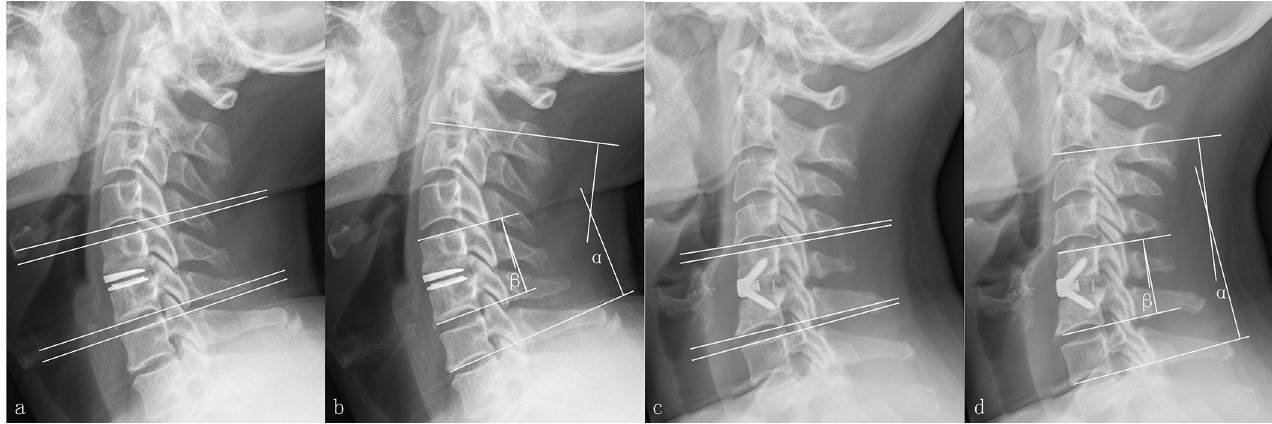
Fig 1. The methods about measurements of radiographic parameters. The range of motion (ROM) at the adjacent levels by disc space angle in the Discover group (a). The overall alignment of C2-C7 ( α ,OSA) and functional spinal unit ( β ,FSU) angle in the Discover group (b). The range of motion (ROM) at the adjacent levels by disc space angle in the Zero-P group (c). The overall alignment of C2-C7 ( α ,OSA) and functional spinal unit ( β ,FSU) angle in the Zero-P group